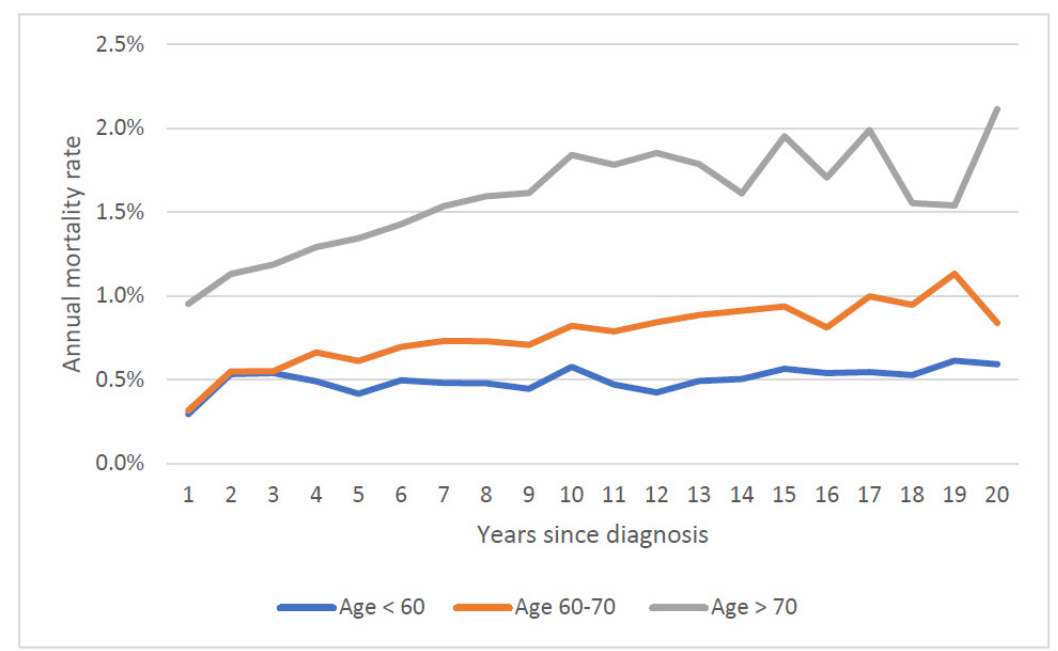
Figure 2. Annual prostate specific mortality rate, by Gleason score.